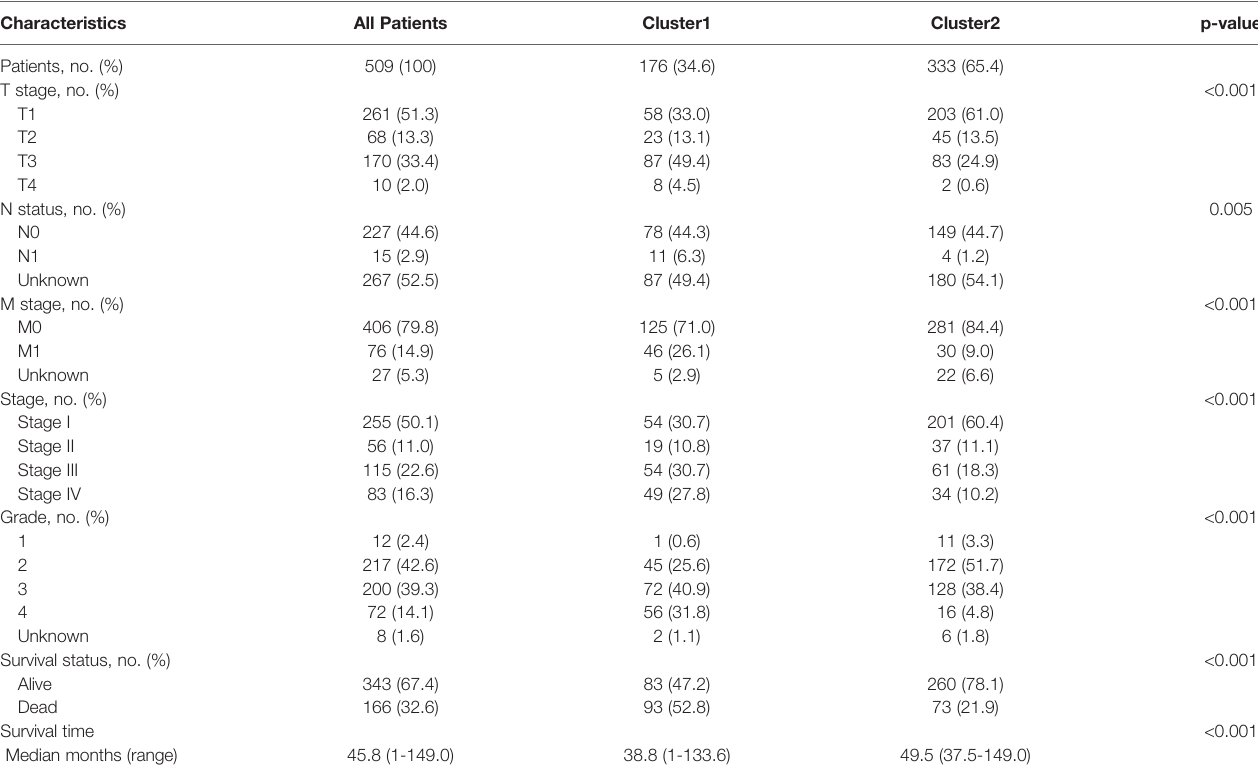
TABLE 1 | Clinicopathological characteristics of ccRCC patients in the TCGA cohort. Characteristics All Patients Patients, no.